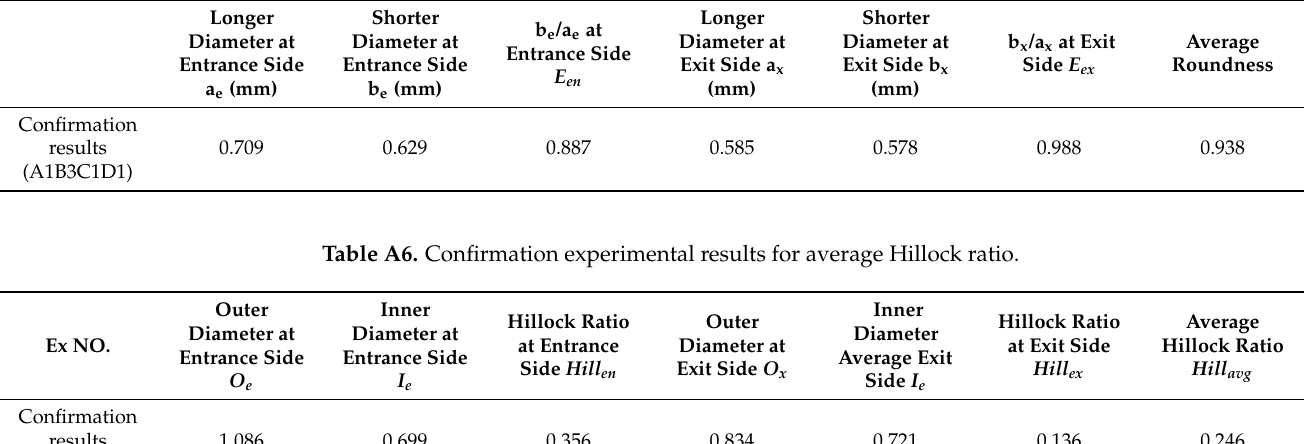
Table A5. Confirmation experimental results for roundness.